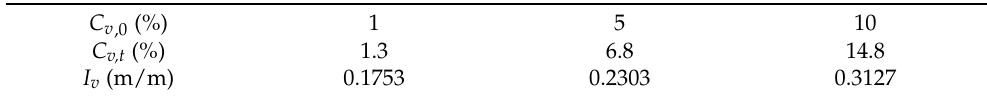
Table 3. Relationship between total pressure drop and initial SVF at V mix ,0 = 4.0 m/s and d s = 15.0 mm. C v ,0 (%)